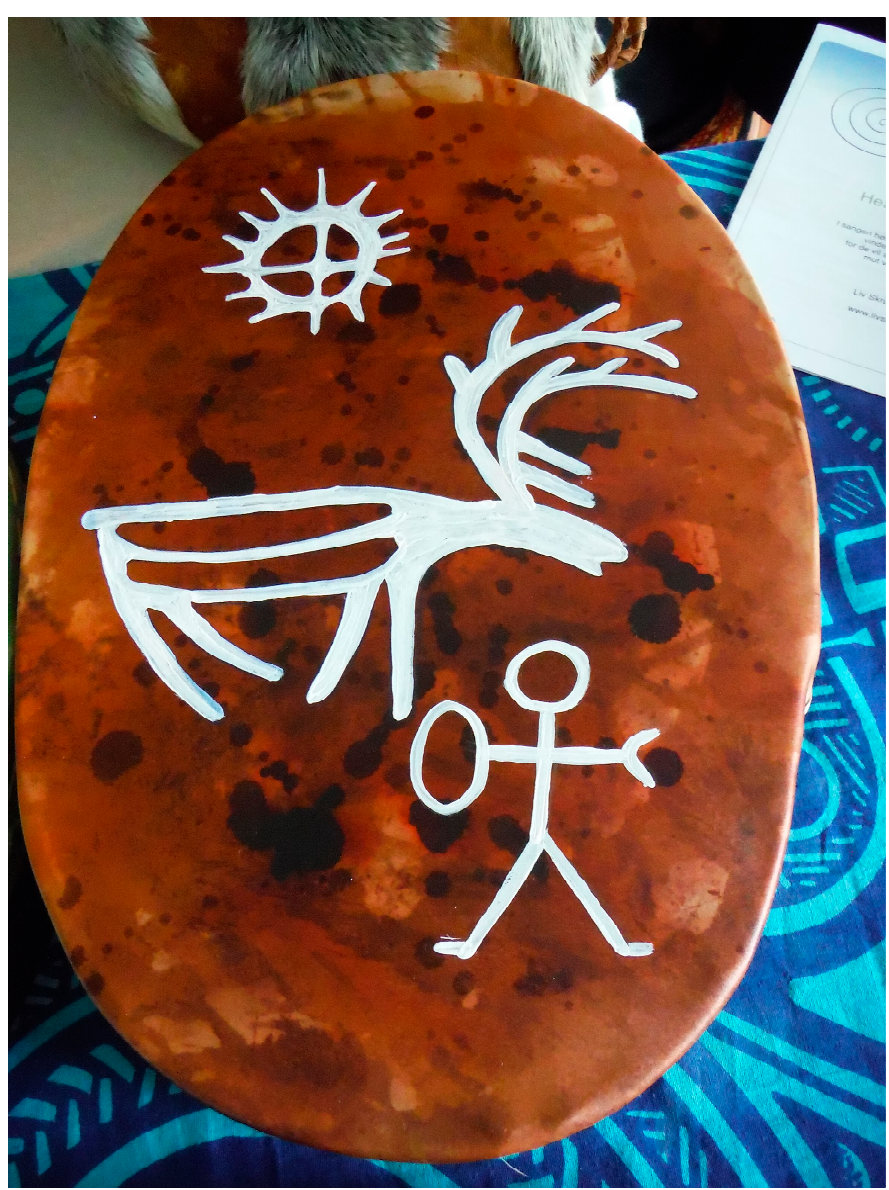
Figure 4. A drum with a reindeer symbol at the fair in Isogaisa (Photo: Tiina Äikäs).